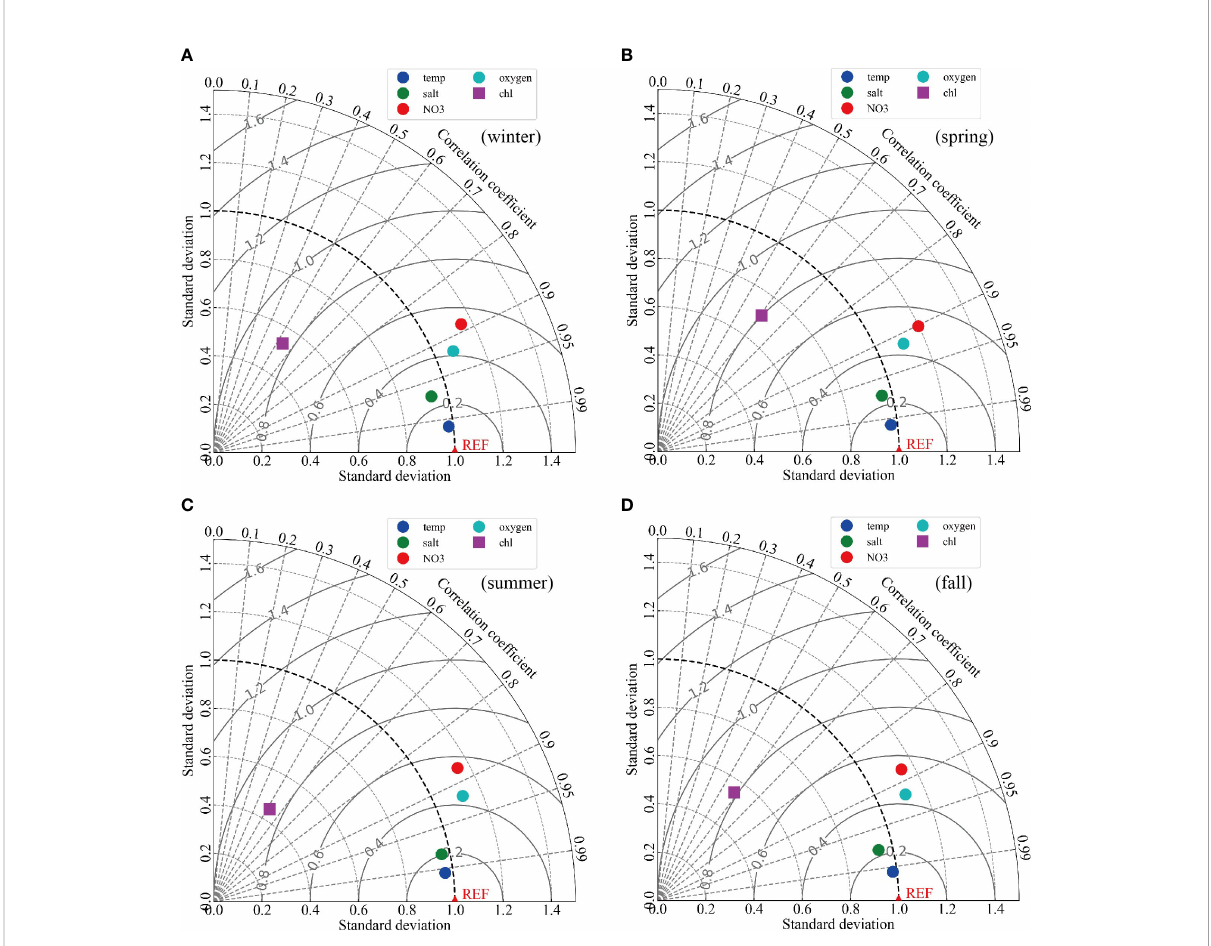
FIGURE 2 Normalized Taylor diagram for statistical comparison of observed and modeled variables of temperature (blue), salinity (green), nitrate (red), oxygen (cyan), and chlorophyll (purple) in winter (A) , spring (B) , summer (C) , and fall (D) . The observation data of temperature, salinity, nitrate, and oxygen are in the upper 800 m from the WOA 2018 dataset, and the chlorophyll data are from the